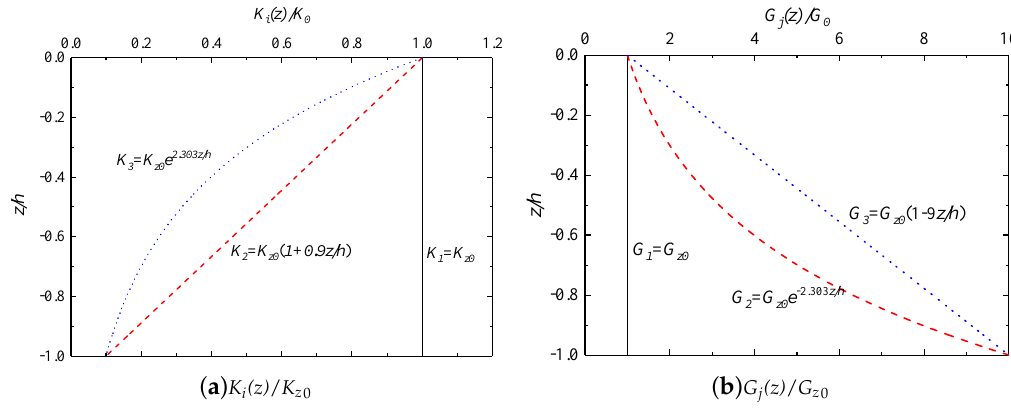
Figure 1. Sketch of the wave–seabed–dumbbell-cofferdam interaction. (unit: cm).